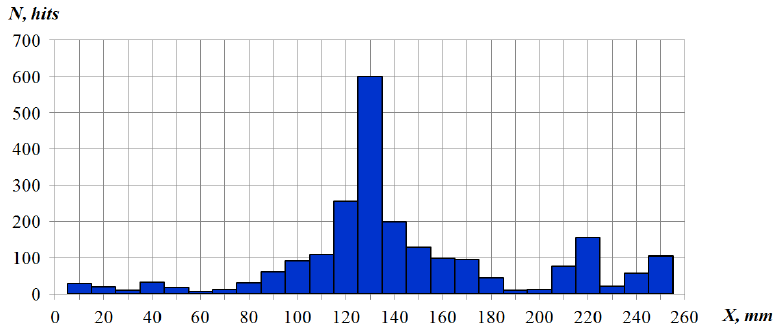
Figure 5. AE sources location pattern for the specimen of 6 mm thick.